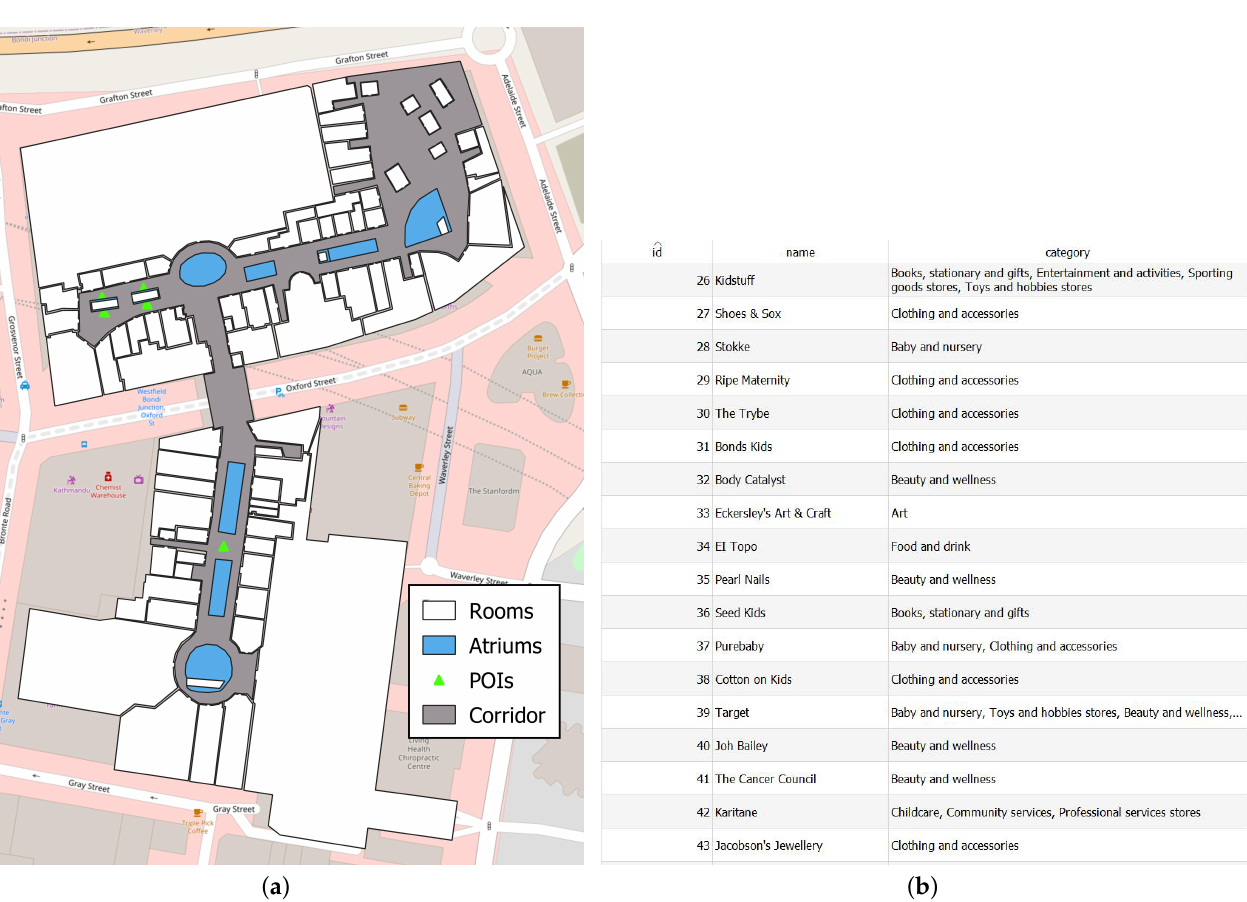
Figure 4. Floor plan of the floor utilized for testing in the shopping mall. ( a ) The floor plan edited in QGIS. ( b ) The attributes of indoor elements.